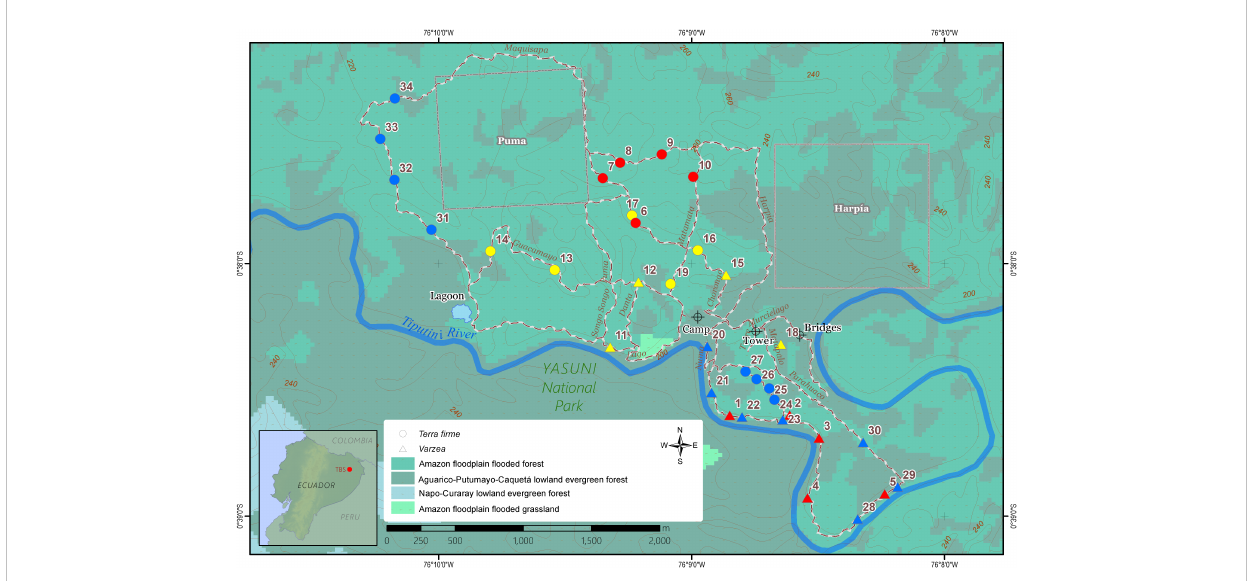
FIGURE 1 Map of the sampling locations for Inga seedling in the Tiputini Biodiversity Station in the Ecuadorian Amazon rainforest. Station trails are represented by intercepted white-brown lines, while the various ecosystem types are depicted in a gradient of green background colors. Triangle symbols Inga collections in va ́ rzea; Circles indicate sampling points in terra fi rme. Colors indicate different sampling expedition: red, November 2018; yellow, August 2019; blue, February 2020. The green to blue color gradient indicates the ecosystem classi fi cation according to the Ecosystem Classi fi cation System of Continental Ecuador. Source: Ministerio del Ambiente del Ecuador